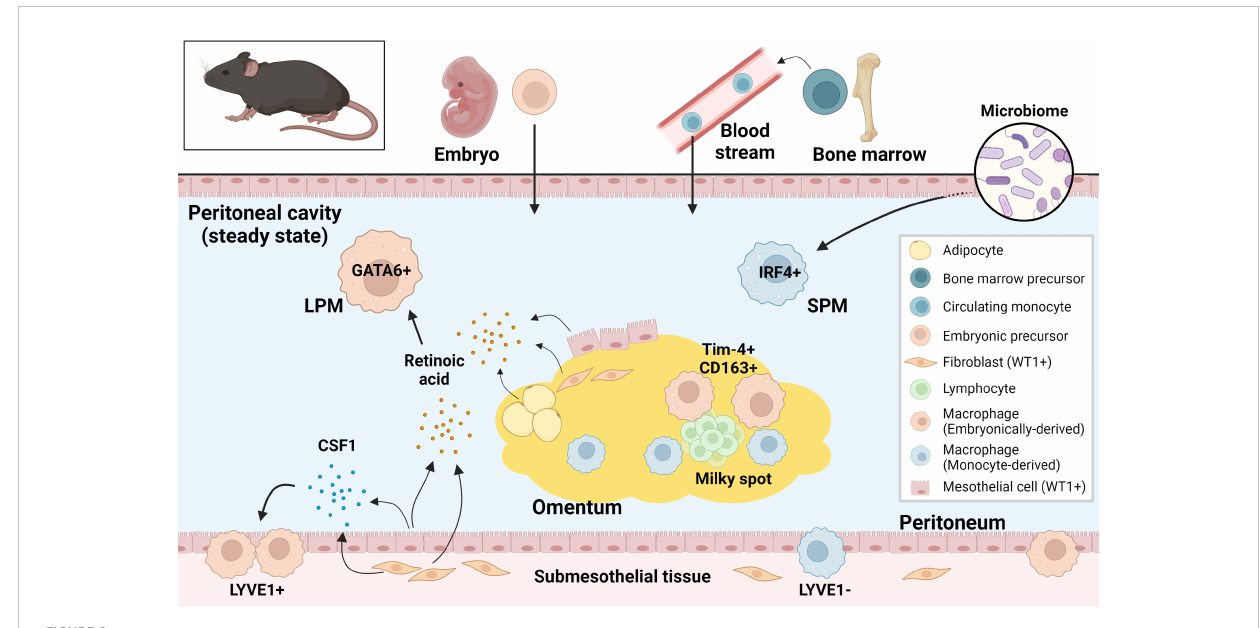
FIGURE 2 Murine resident peritoneal macrophages and their supporting environment at steady state. Both embryonically-derived and monocyte-derived resident macrophages are present in murine peritoneal cavity at steady state. These resident macrophages from different origins are regulated differently in the tissue-speci fi c niche. LPM, large peritoneal macrophage; SPM, small peritoneal macrophage; CSF1, colony stimulating factor 1; WT1, Wilms tumor